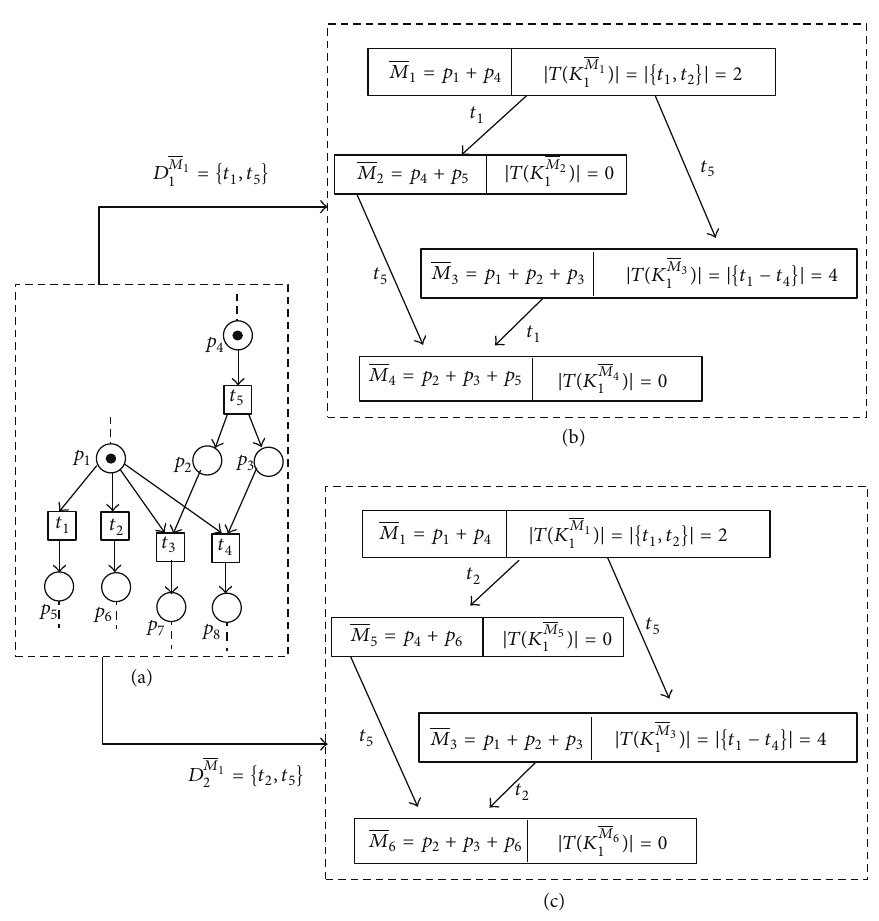
Figure 4: The partial reachability graph of a CIC (𝑁 1 ,𝑀 1 ) with |𝑇(𝐾 1 )| = 4 by concurrently firing transitions in 𝐷 𝑀 1 1 = {𝑡 1 ,𝑡 5 } and 𝐷 𝑀 1 2 = , 𝑡 } {𝑡 2 5